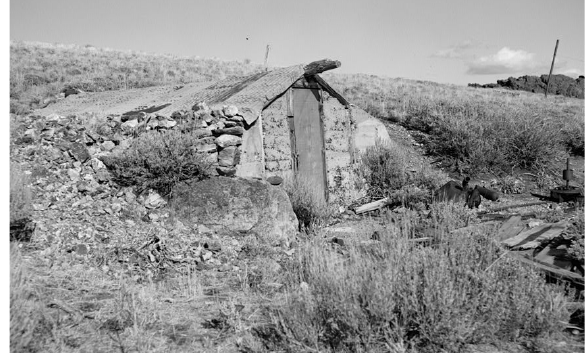
Figure 3. Bell Family Residence, Dugout, East slope of Buckskin Mountain, Paradise Valley, Humboldt County, NV (Source: Historic American Engineering Record - Library of Congress).